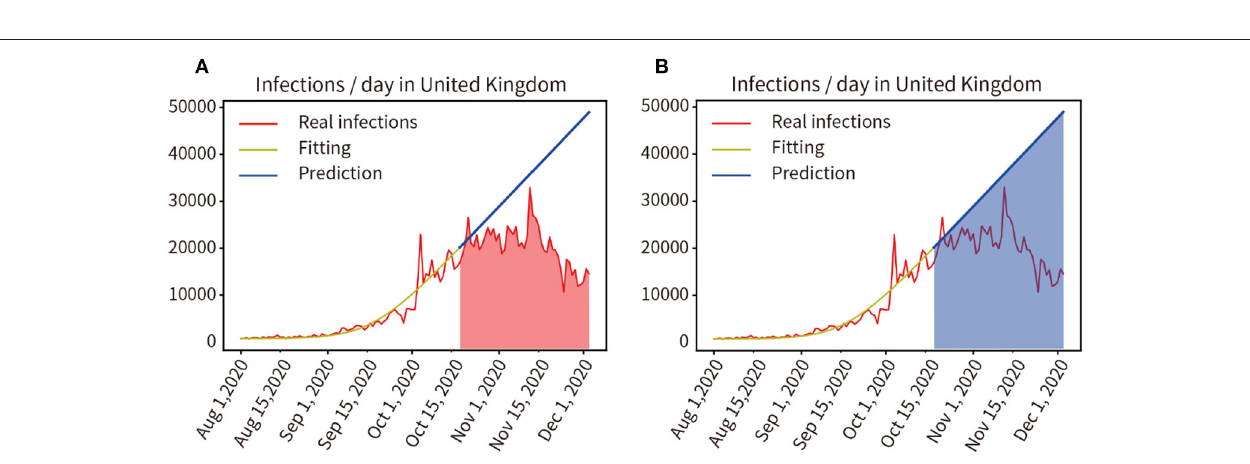
FIGURE 8 | (A,B) Quantitative analysis of the impact of the three-tier social blockade on the pandemic in the